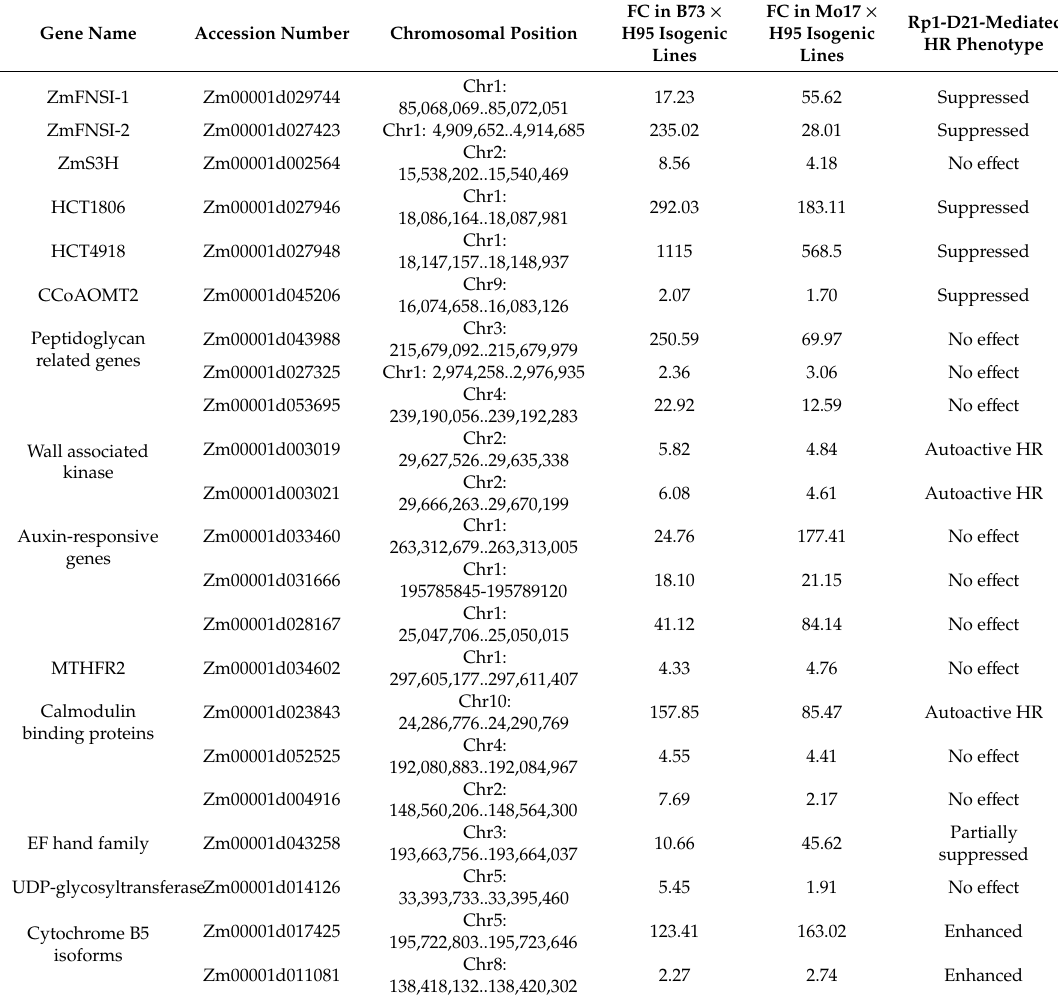
Table 1. The fold change (FC) of the transcript levels of maize genes in Rp1-D21 compared to the corresponding wild type and the e ff ect of the genes on the Rp1-D21-mediated hypersensitive response